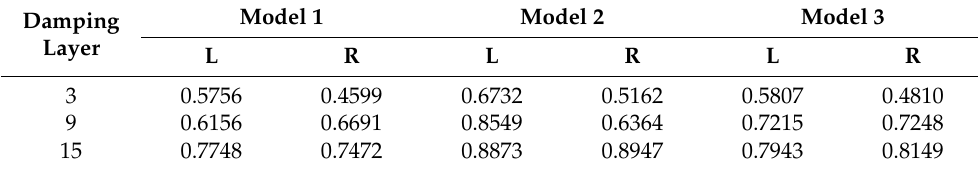
Table 4. Damping effects for the base shear (El Centro).